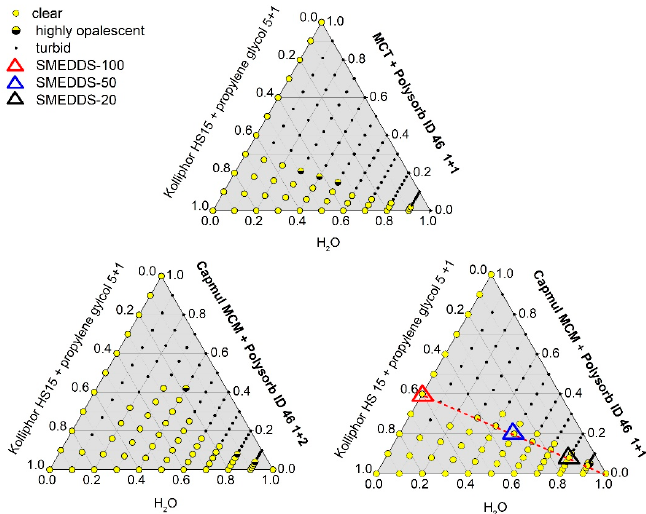
Figure 2. Impact of the composition of the lipid components on the phase behavior: ternary phase diagrams (25 °C) of pseudo ternary mixtures of ( I ) distilled water, ( II ) surfactant/co-surfactant and ( III ) lipid excipients. Any formulations that did not appear completely clear (ranging from slightly cloudy to milky white) were classified as turbid. Open triangles show the formulations SMEDDS-100; SMEDDS-50 and SMEDDS-20 which were selected for further detailed studies. The dotted line indicates the dilution pathway of the SMEDDS-100